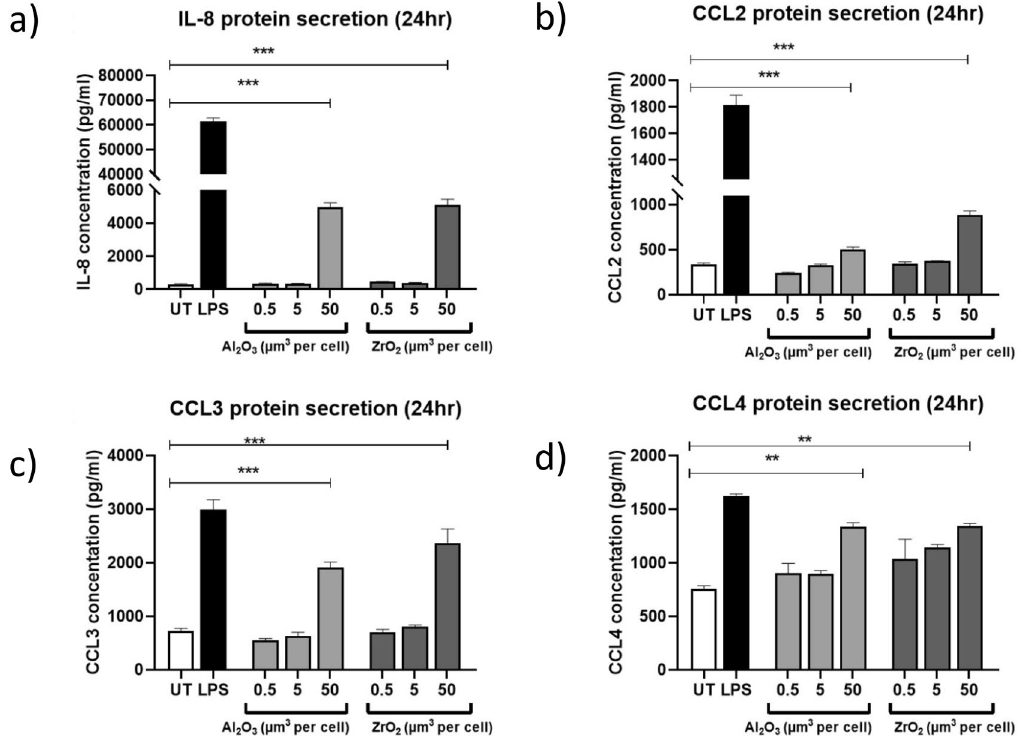
Figure 4. THP-1 macrophage protein secretion following treatment with metal ceramic oxide nanopowders for 24 h. THP-1 macrophages activated with PMA and treated with Al 2 O 3 or ZrO 2 (0.5–50 µm 3 particles per cell) for 24 h. Supernatant was collected and used in conjunction with an ELISA platform to quantify protein secretion. In all cases, untreated cells were included as a negative control and LPS-treated (10 ng/mL) THP-1 macrophages were used as a positive control. ( a ) THP-1 macrophages experienced significant increases in the secretion of IL-8 following treatment with 50 µm 3 particles per cell Al 2 O 3 (P = 0.0002) and ZrO 2 (P = 0.0001). ( b ) Both Al 2 O 3 -treated and ZrO 2 -treated THP-1 macrophages had significant increases in CCL2 protein secretion following a 24 h treatment time (both P < 0.0001). ( c ) CCL3 protein secretion increased significant after a 24 h incubation with 50 µm 3 particles per cell Al 2 O 3 (P < 0.0001) and ZrO 2 (P < 0.0001). ( D ) At the highest dosage of Al 2 O 3 and ZrO 2 CCL4 protein secretion significantly increased compared to an untreated control (Al 2 O 3 P = 0.0095) and ZrO 2 (P = 0.0092). All data presented here is representative of n =